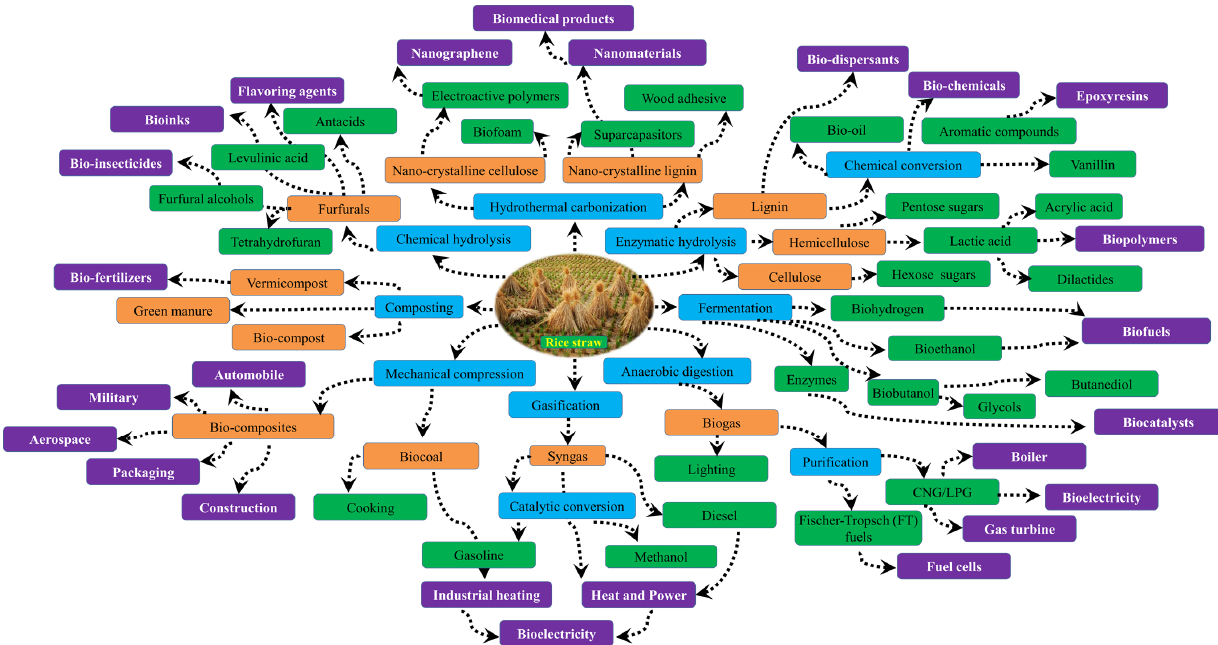
Figure 1. Potential value added products from rice straw biorefinery and their applications.